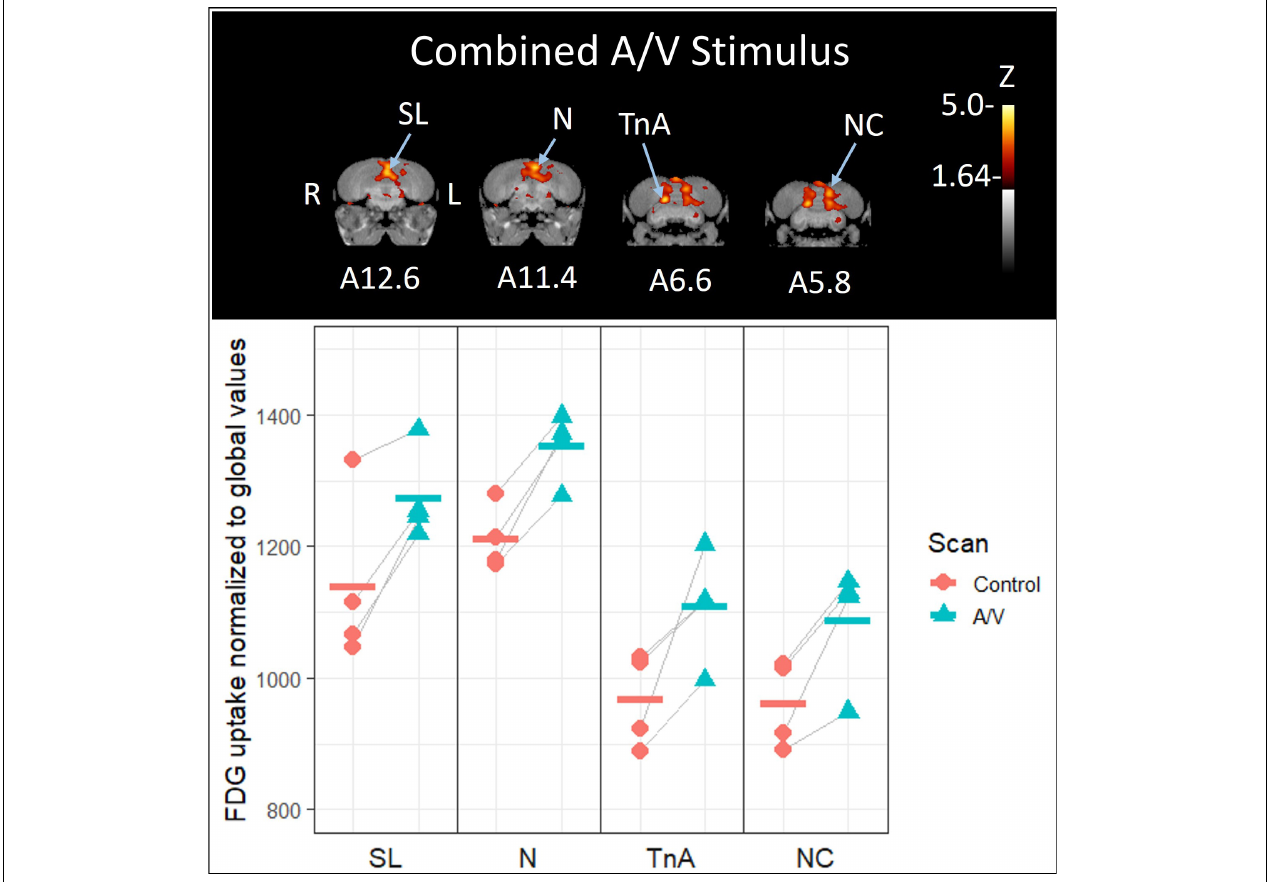
FIGURE 4 | Top: Coronal view of voxel-wise subtractions (converted to Z-scores) showing differential brain activity at the indicated region for all crows simultaneously exposed to the vocalizations of feeding crows and the sight of their preferred food item during their stimulus scan ( n = 4). Brain activity is superimposed atop a composite ( n = 4) structural MRI of the American crow brain. Slice coordinates (A12.6, A11.4, A6.6, and A5.8) refer to the Izawa and Watanabe (2007) jungle crow atlas. Bottom: individual values for normalized (global) uptake obtained from VOI’s centered on peak activation coordinates. Horizontal lines indicate group means. Note that while the nucleus taeniae of the amygdala (TnA), and nidopallium (N) showed significant increases in FDG uptake, the lateral septum (SL) and caudal nidopallium (NC) did not meet the critical